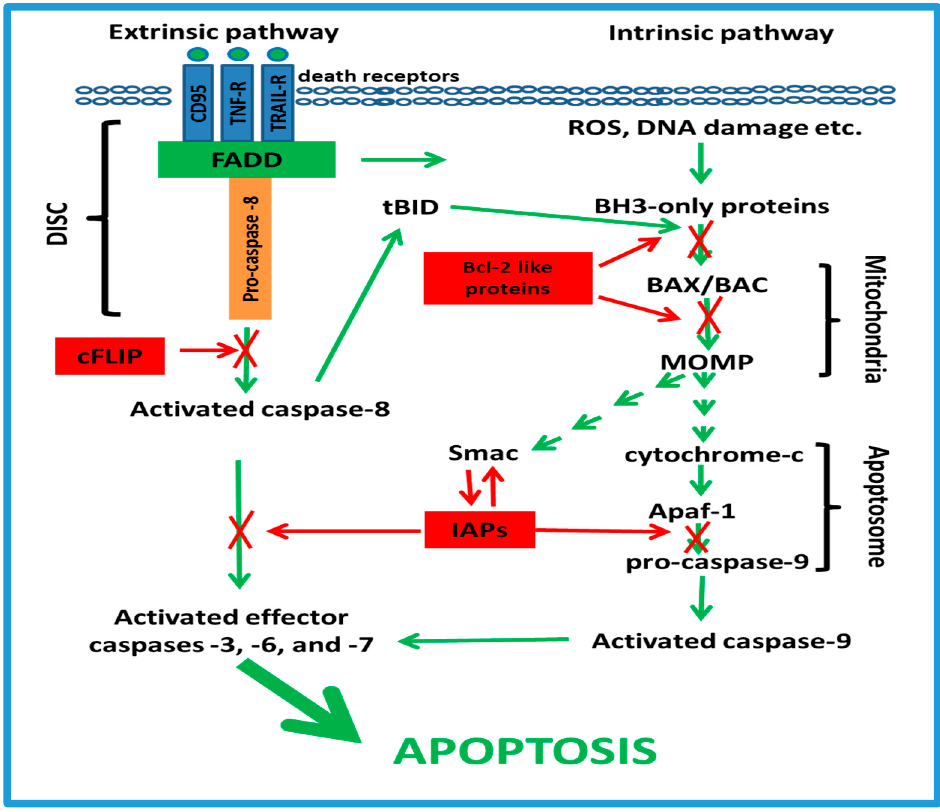
Figure 1. Anti-apoptotic mechanisms contributing to chemotherapy resistance in cancer cells. Extrinsic apoptotic pathways in tumors may be suppressed by downregulation of cell surface death receptors or/and overexpression of cFLIP; intrinsic (mitochondrial) apoptosis is blocked by up-regulation of Bcl-2-like proteins, and both pathways can be terminated by IAPs. FADD—FAS associated protein with death domain; DISC—the death-inducing signaling complex; cFLIP—the cellular FLICE (caspase 8)-like inhibitory protein; tBID—truncated Bid protein; MOMP—mitochondrial outer membrane permeabilization; Smac—second mitochondria-derived activator of caspases; Apaf 1—apoptotic protease activating factor 1; IAPs—inhibitor of apoptosis proteins. TRAIL. Note: green arrows—activation, red arrows—suppression, X—blocking. For example, monesin, medicarpin, diallyl trisulfide, tunicamycin, and 5,7-dimethoxyflavone initiated up-regulation of death receptor 5 (DR5) in glioma, myeloid leukemia, human melanoma and hepatocellular carcinoma cells via the unfolded protein response [121–125]. Addition of proteasome inhibitor PS-341 (VELCADE, bortezomib) sensitized prostate cancer cells to TRAIL-induced apoptosis by increasing DR5 inhibiting protein degradation, and elevating DR5 mRNA [126]. TRAIL- resistant prostate cancer cells, glioma and HeLa cells have also been sensitized by inhibition of heat shock proteins 90 and 27 with geldanamycin, and small molecules 17-AAG and LY303511 [127–129]. In addition, targeting p53 [130], autophagy [131], protein synthesis [132] and epigenetic modulation [133] by different agents have been reported to increase sensitivity of breast, myeloid, lung, brain, skin, cervical and colon cancer cells to TRAIL therapy.